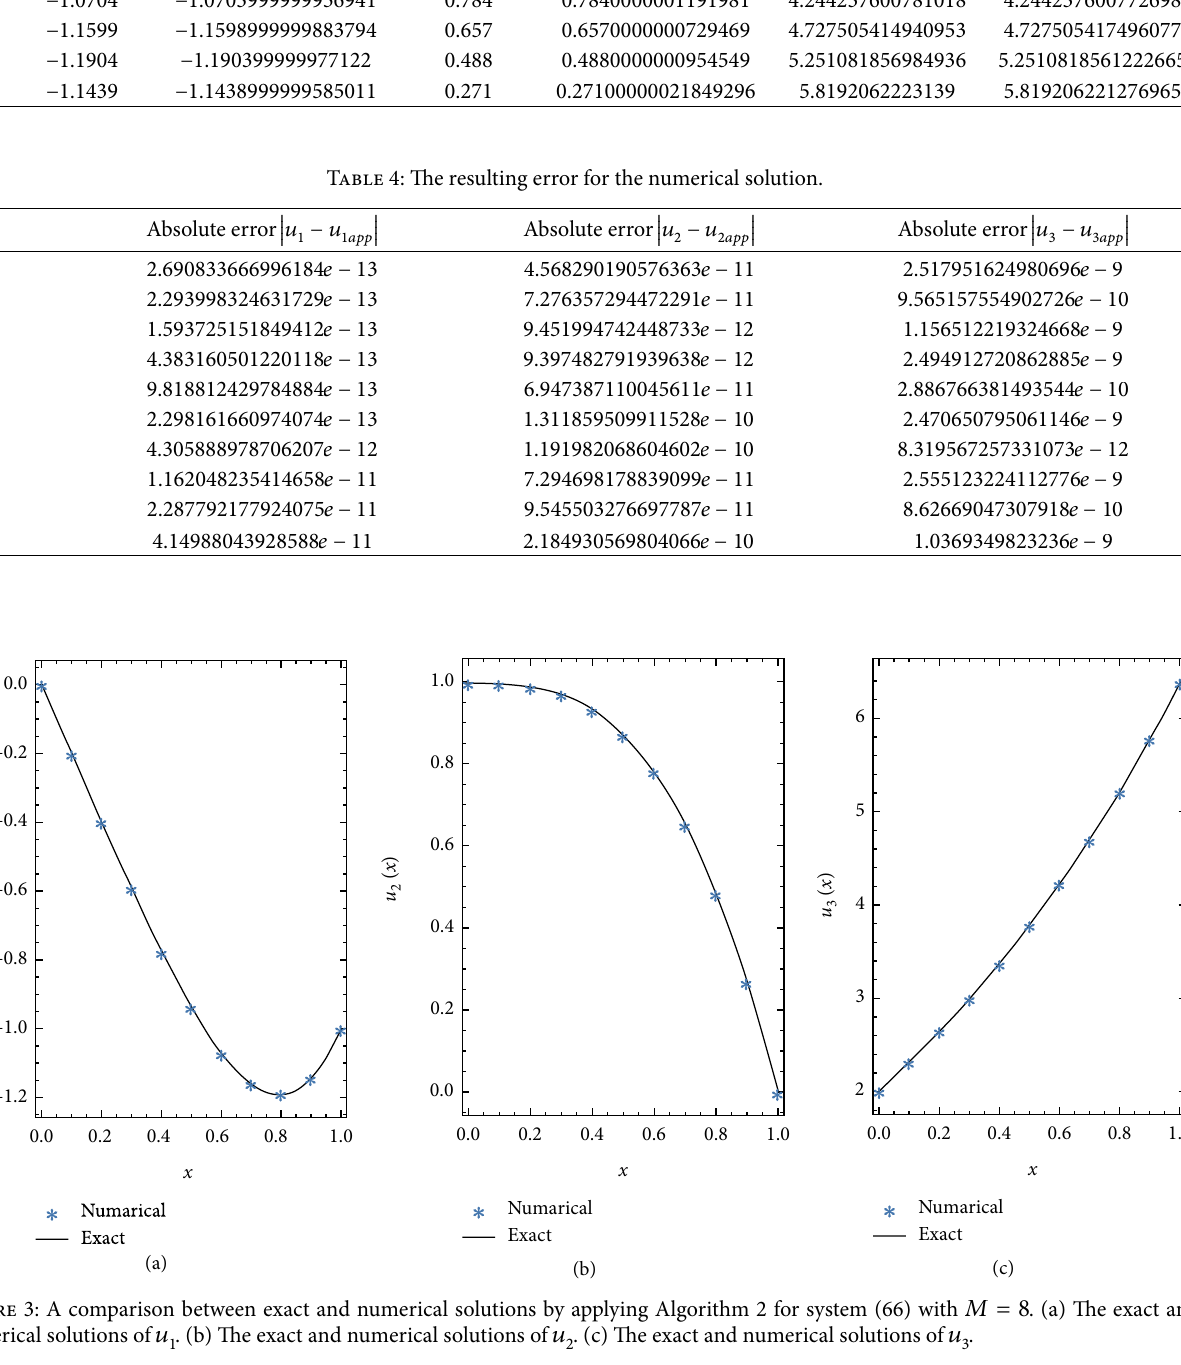
. (c) The exact and numerical solutions of 𝑢 2